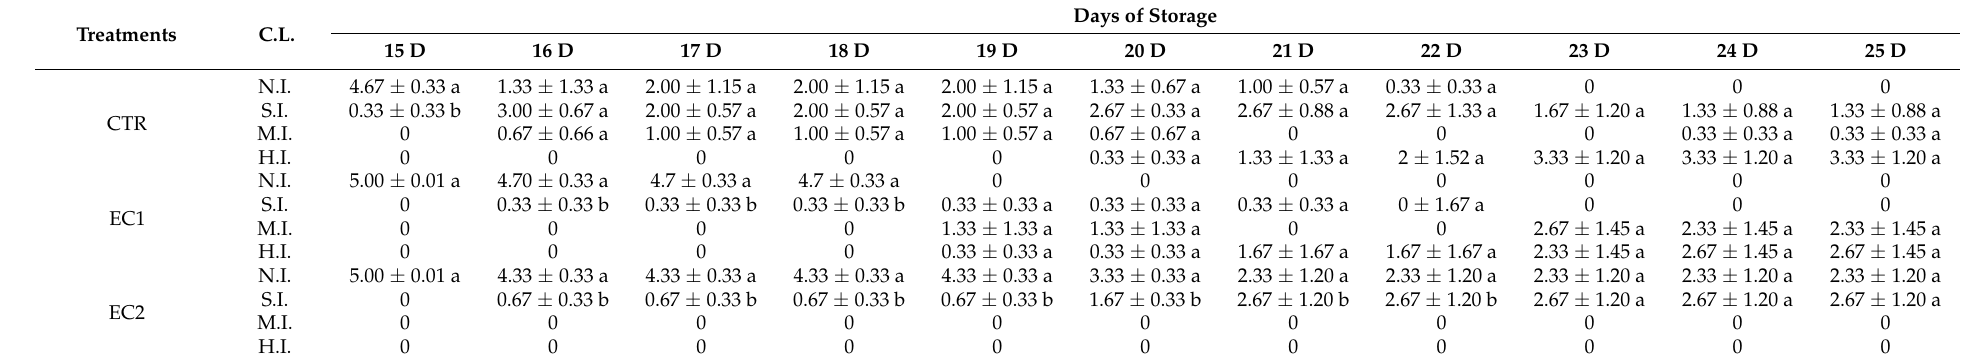
Table 2. Development over time of daily mean values of contamination levels in fruit of C. papaya L. treated with different extracts from O. vulgare subsp. viridulum L. The levels of contamination (C.L.) are described as follows: N.I. (no infection—level 0); S.I. (slight infection, 1–4 lesions liv.1); M.I. (moderate infection, 5–10 lesions, liv.2); and H.I. (high infection, >10 lesions, liv.3). Each value refers to the average of three repetitions ± S.E. CTR = control; EC1 = A. arborescens and essential oil; and EC2 = only hydrolate. The values with the same letter are not significantly different at p ≤ 0.05 (Tukey’s test). The lowercase letters in the apex are used to indicate differences in time for the same treatment; the uppercase letters indicate differences between treatments at the same time of storage. For each treatment, different letters are indicated significant differences between sampling